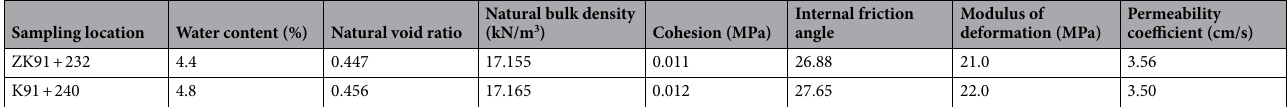
Sampling location Water content (%) Natural void ratio